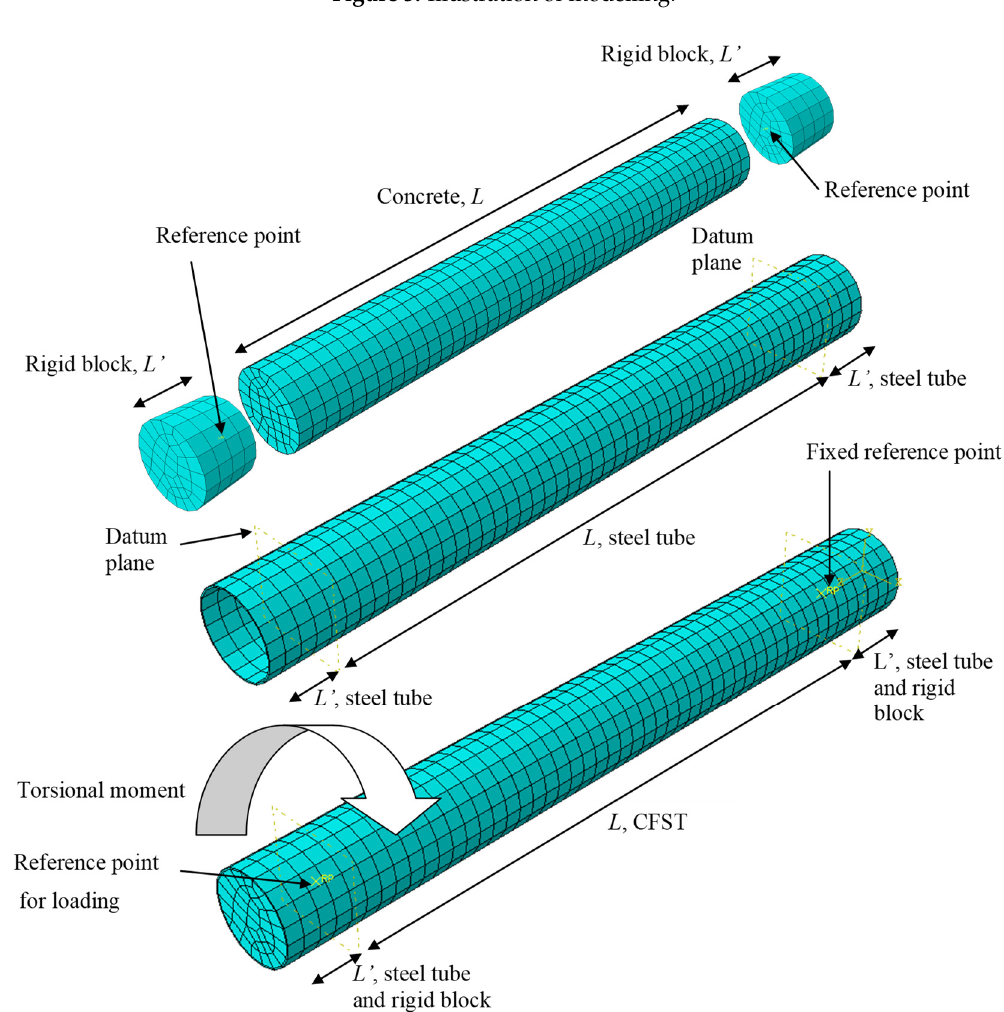
Figure 4. Details in modelling CFST under torsion.